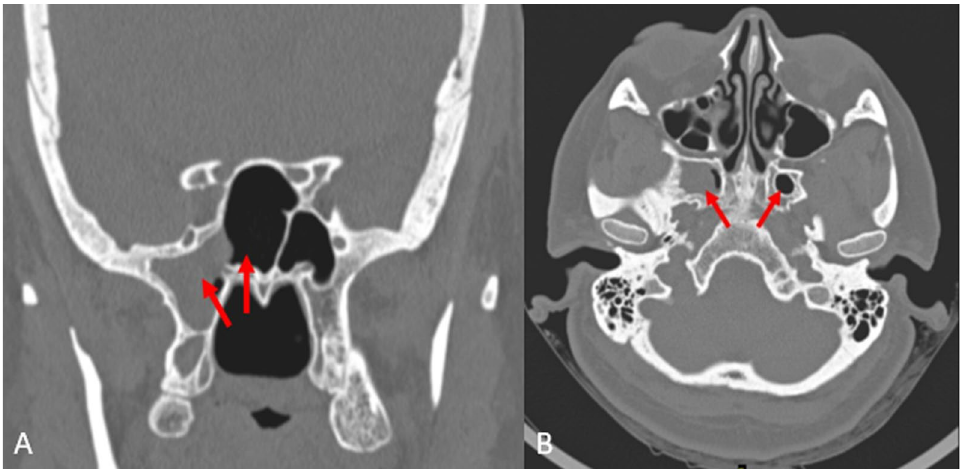
Fig. 4 A 49-year-old female presented with history of right sided watery nasal discharge. A Plain CT PNS coronal section showing the hyper-pneumatized right sphenoid bone (vertical red arrow) with mucosal thickening within (oblique red arrow) and B axial section showing the hyper-pneumatized bilateral pterygoid bones (red arrows) with opacification on the right side by mucosal